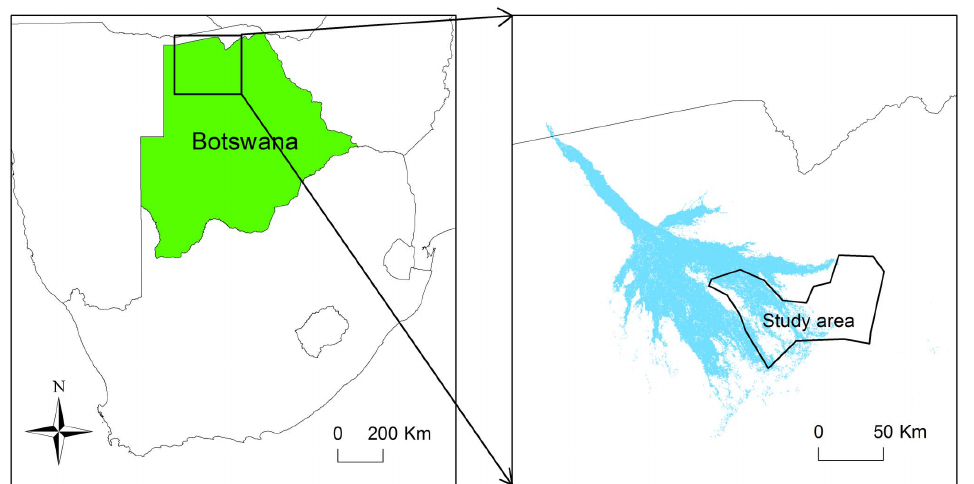
Figure 2. Location of study area in Botswana. The permanently flooded areas of the Okavango Delta are shown in blue in the right-hand image.